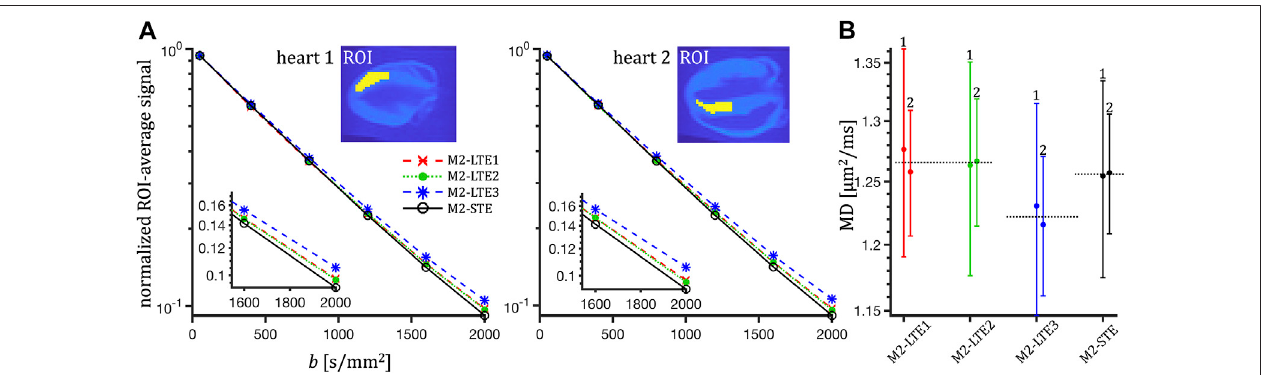
FIGURE 6 | ROI and rotation-averaged signals from mouse hearts measured with acceleration compensated waveforms (M2-LTE and M2-STE) at high b-values (A) and MD estimates (B) . The LTE waveforms correspond to the individual channels from theSTE. In panel A, a small deviation can be seen between signals measured with STE and LTE, attributed to microscopic anisotropy. The signals for LTE1 and LTE2 coincide well. The largest deviation from STE occurs for LTE3, which has more encodingpoweratlowfrequencies(see Figure2